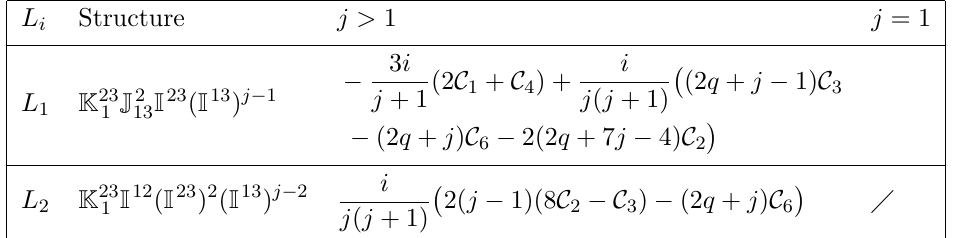
( QO ) T ( QO ) when QO h i